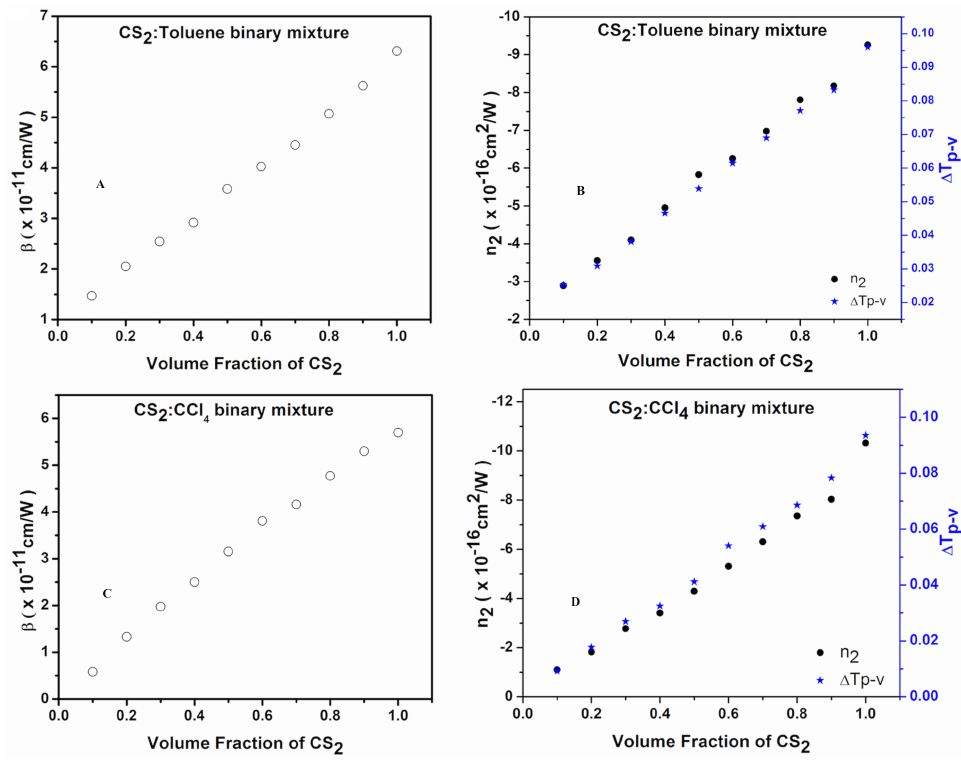
Figure 7 Variations in the respective NLO properties ( β ) and (n 2 ) with changing volume fraction of carbon disulfide in binary liquid mixtures of carbon disulfide with toluene and carbon disulfide with CCl4 in CAZS without-flow experiments. Full-size DOI: